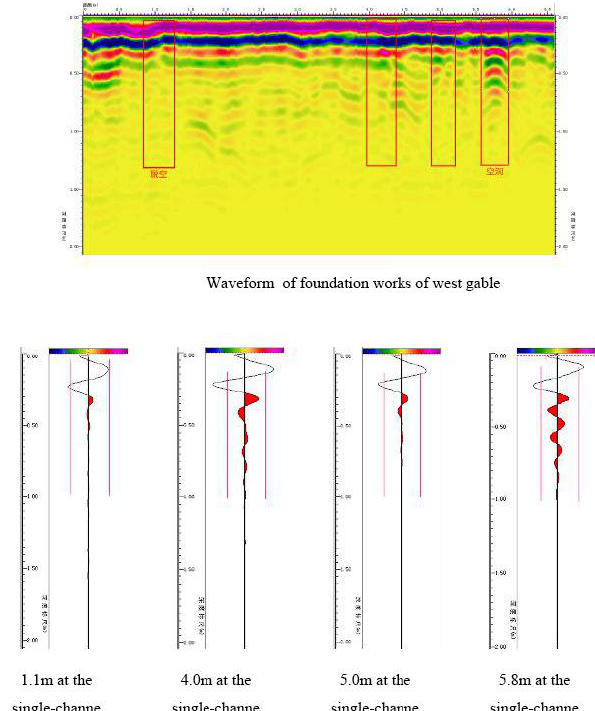
Figure 21 GPR detection analysis of the temple gate of the west gable